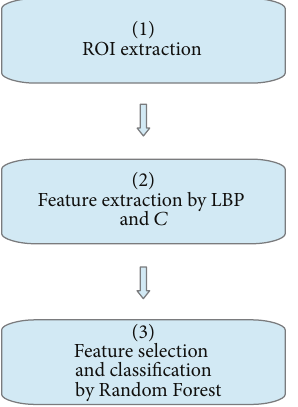
Figure 2: Overview of proposed method. See Section 5.1 for